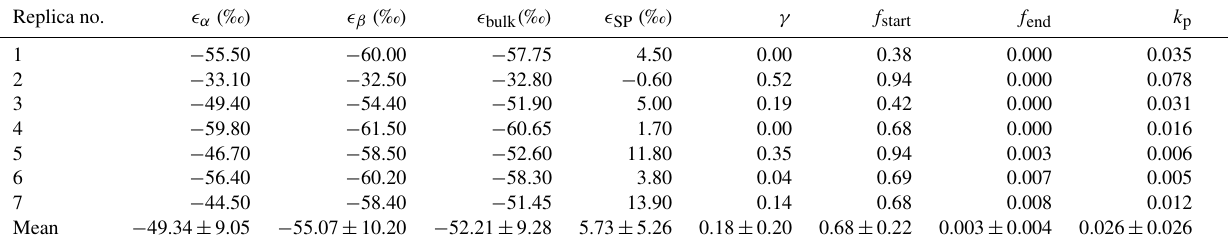
Figure 3. Continuous measurements of (a) N 2 O concentrations and (b) the net N 2 O production rate from experiments with P. fluorescens (green) and P. chlororaphis (blue), respectively. Only the first 120min of the net N 2 O production are shown. Note that the scaling of the two horizontal axes differs. Table 2. Isotopic fractionation, reduction correction parameter ( γ ), extremes of the unreacted fraction parameter ( f start and f end ), and production rate ( k p ) in ppm(minmL KNO 3 ) − 1 for the production of N 2 O from P. fluorescens . Replica